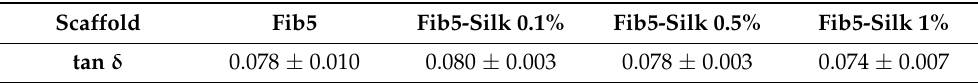
Figure 3. Scanning electron microscopy (SEM) images of fibrin and fibrin/silk fibroin scaffolds. ( a , b ) Fibrin scaffold at 5 mg/mL (without ethanol treatment). ( c , d ) Fibrin at 5 mg/mL with ethanol treatment. ( e , f ) Composite of fibrin (5 mg/mL) and silk fibroin (0.1% w/w ). ( g , h ) Composite of fibrin (5 mg/mL) and silk fibroin (0.5% w / w ). ( i , j ) Composite of fibrin (5 mg/mL) and silk fibroin (1% w/w ). To determine if the scaffolds behave in a more elastic way than in a viscous way, or vice versa , the elastic moduli values (G (cid:48) ) were compared with the viscous ones (G (cid:48)(cid:48) ), as represented in Table 2. The loss factor (tan delta), that is, the ratio between G (cid:48)(cid:48) and G (cid:48) , was lower than 0.1 for all the tested scaffolds (see Table 2). In other words, the elastic moduli were more than 10 times higher than the viscous moduli, which indicates a predominantly elastic behavior of the scaffolds. Table 2. Values of the delta tangent (tan δ = G (cid:48)(cid:48) /G (cid:48) ) for the ethanol-treated scaffolds, expressed as mean ±